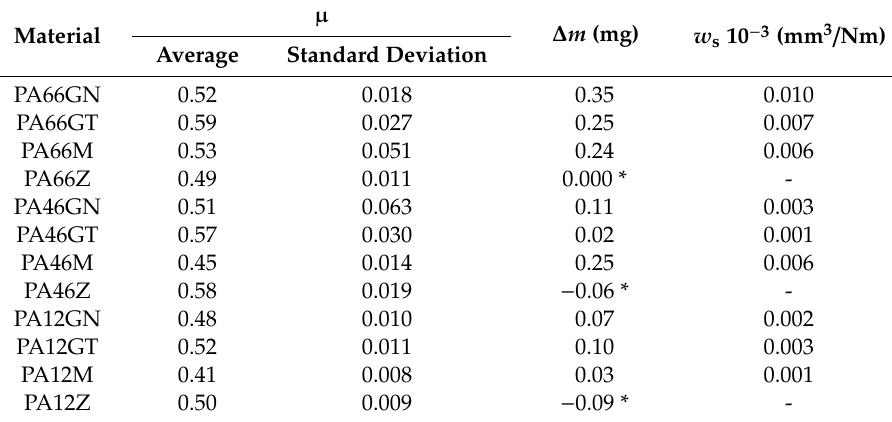
Table 2. Summary of wear test results for hybrid